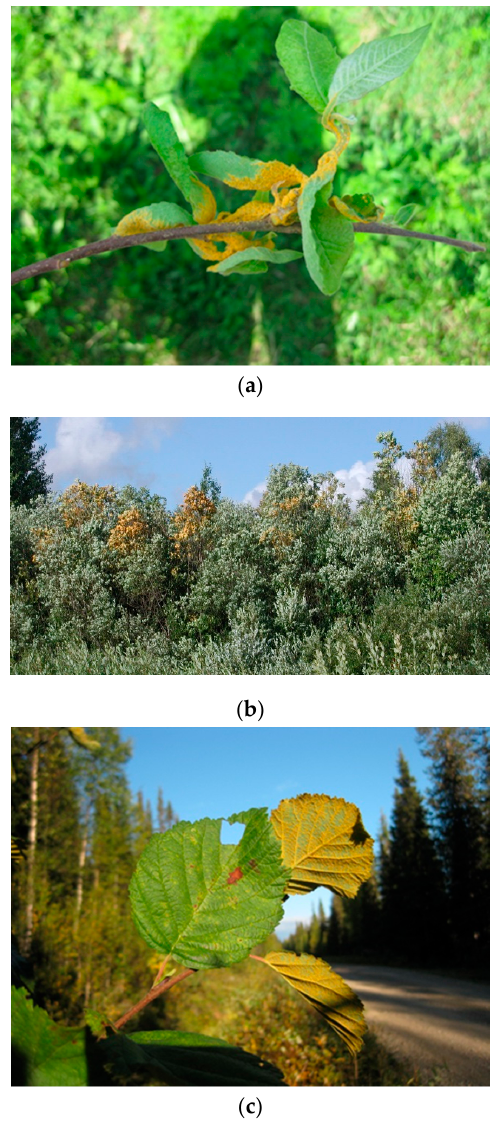
Figure 6. Rust on broadleaved trees. ( a ) Systemic-like infection and sporulation of Melampsora sp. on Salix caprea , Rovaniemi, 2 June 2009; ( b ) Salix pentandra trees or bushes can easily be detected when heavily infected by Melampsora laricis-pentandrae , Tervola, 5 August 2005; ( c ) A shoot of Alnus incana infected by Melampsoridium hiratsukanum in Kivalo Research Forest, Rovaniemi, 2 September 2013. Already in the 1980s, M. laricis-pentandrae became an annual phenomenon on S. pentandra L., a common species in southern Lapland. Heavily infected bay-leaf willows can be seen from July onwards every summer (Figure 6b), and the few occasionally planted poplars, mainly balsam and black poplars, become heavily infested by M. laricis-populina from late July, irrespective of the summer climatic conditions. Heavy infections have occurred in the last 10–15 years. The most common rust fungus that can alternate between birch and larch is Melampsoridium betulinum (Pers.) Kleb., the basidiomycete causing birch rust disease [48]. During a wet summer, outbreaks of this rust occur on most birch species, which are increasingly frequent on silver birch due to a different race of the pathogen [46]. The disease is most severe in pubescent birch, which appears naturally and abundantly in every stand in Lapland. The pathogen has the uredinial state on leaves